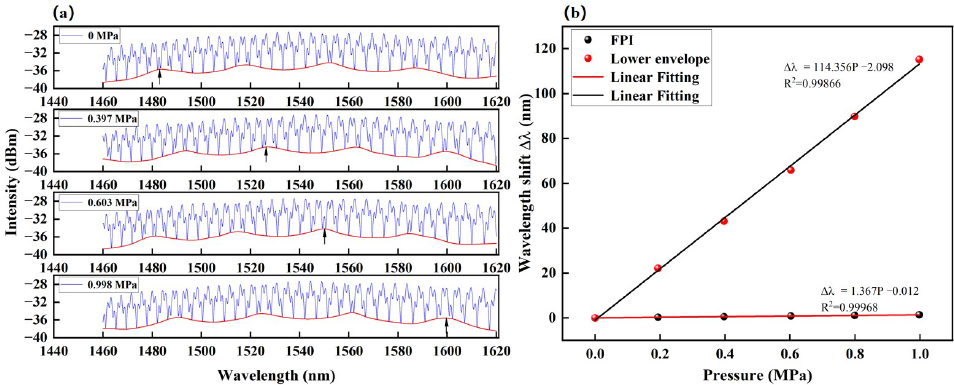
Figure 7. ( a ) The shift of the reflective spectra envelope versus gas pressure. ( b ) The pressure re- sponse of the Vernier envelope and FPI. of the Vernier envelope and